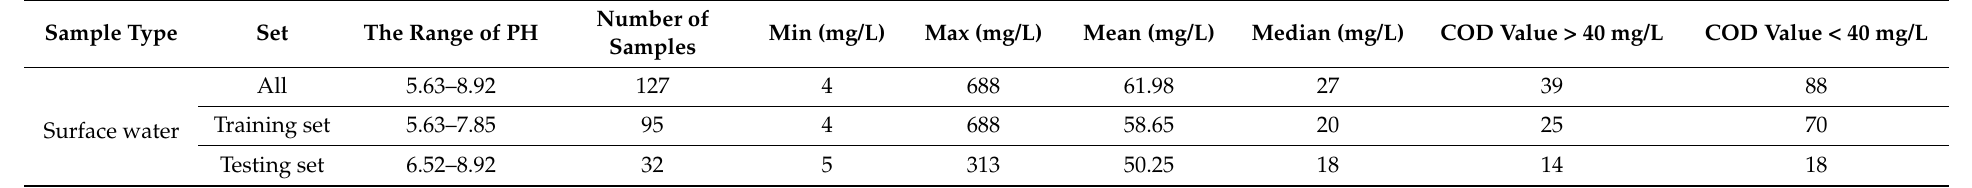
Table 1. Statistics of surface water COD values and partitioning of sample